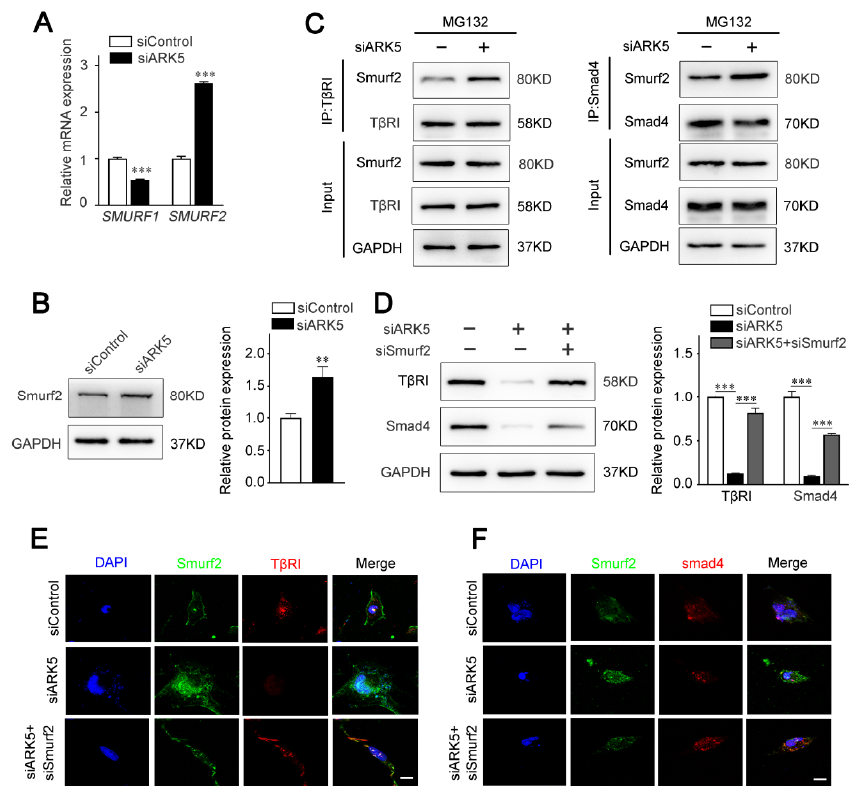
Figure 5. ARK5 protects T β RI and Smad4 from Smurf2 mediated degradation. ( A ) Quantitative